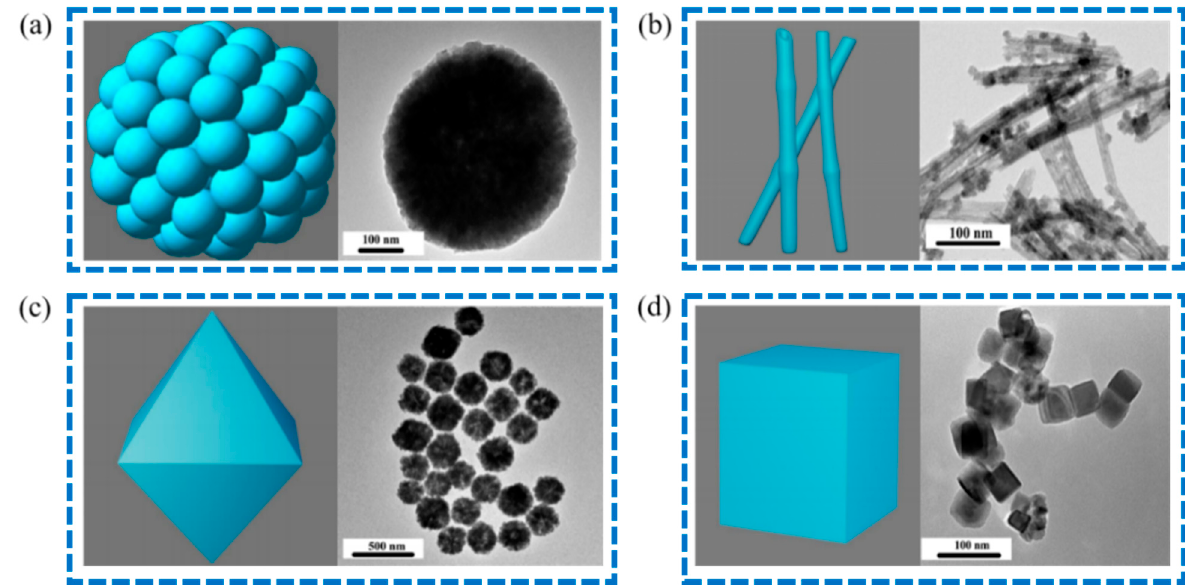
Figure 1. Scheme and transmission electron microscopy (TEM) images of nanoscale cerium oxide with different morphologies [41]. ( a ) Nanosphere. ( b ) Stick. ( c ) Octahedron. ( d ) Cube. Copyright 2018 John Wiley and Sons .